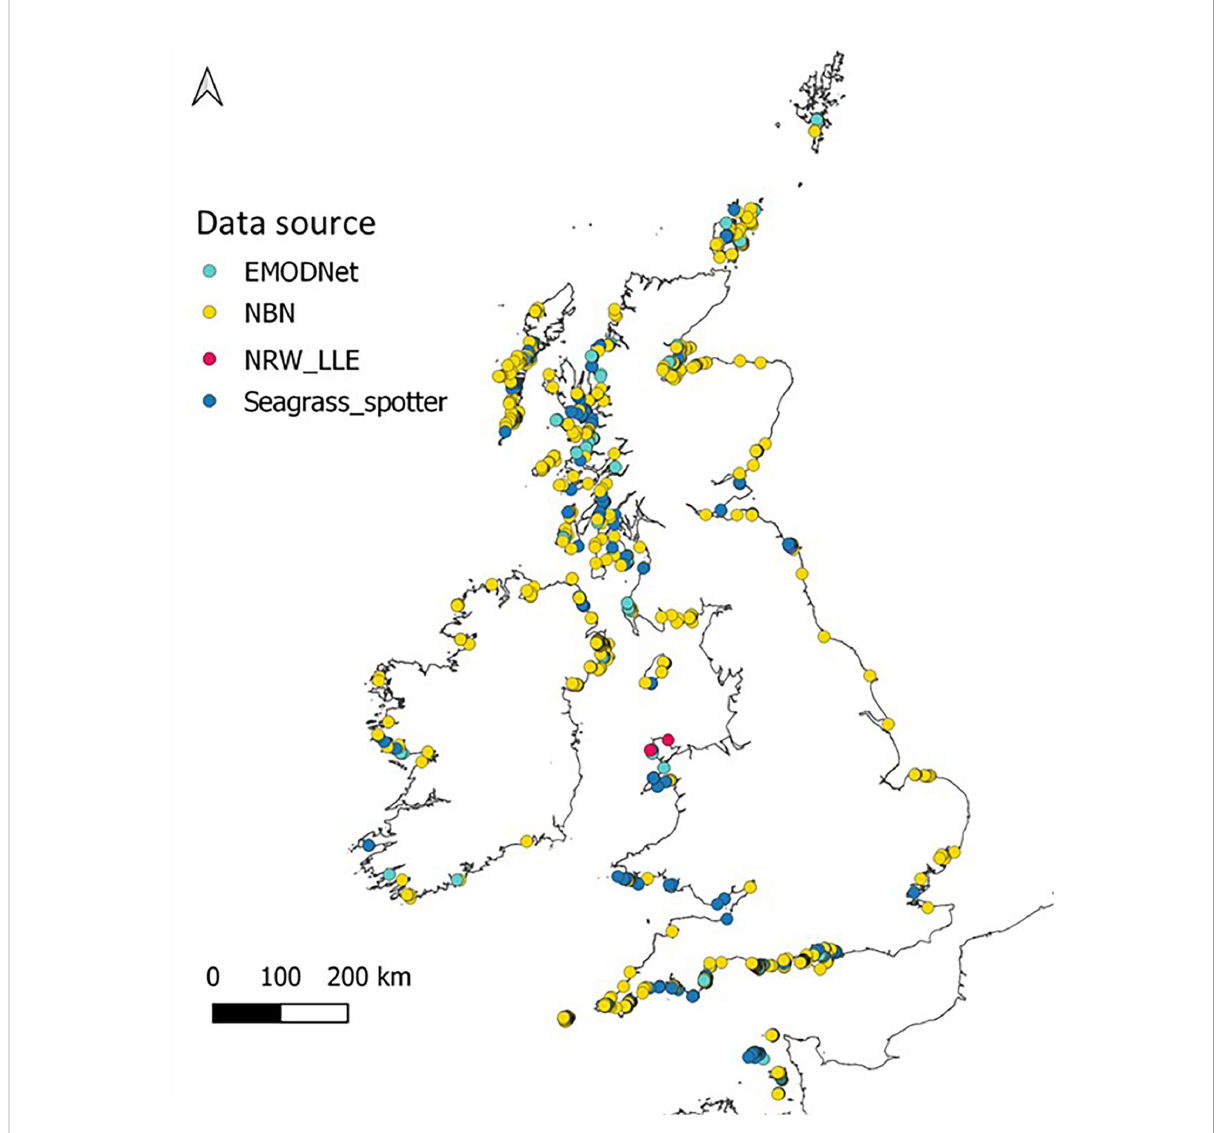
FIGURE 2 Zostera marina presence around the UK, Ireland and the Channel Islands taken from sources listed in Supplementary Data (Table S1) after outliers were